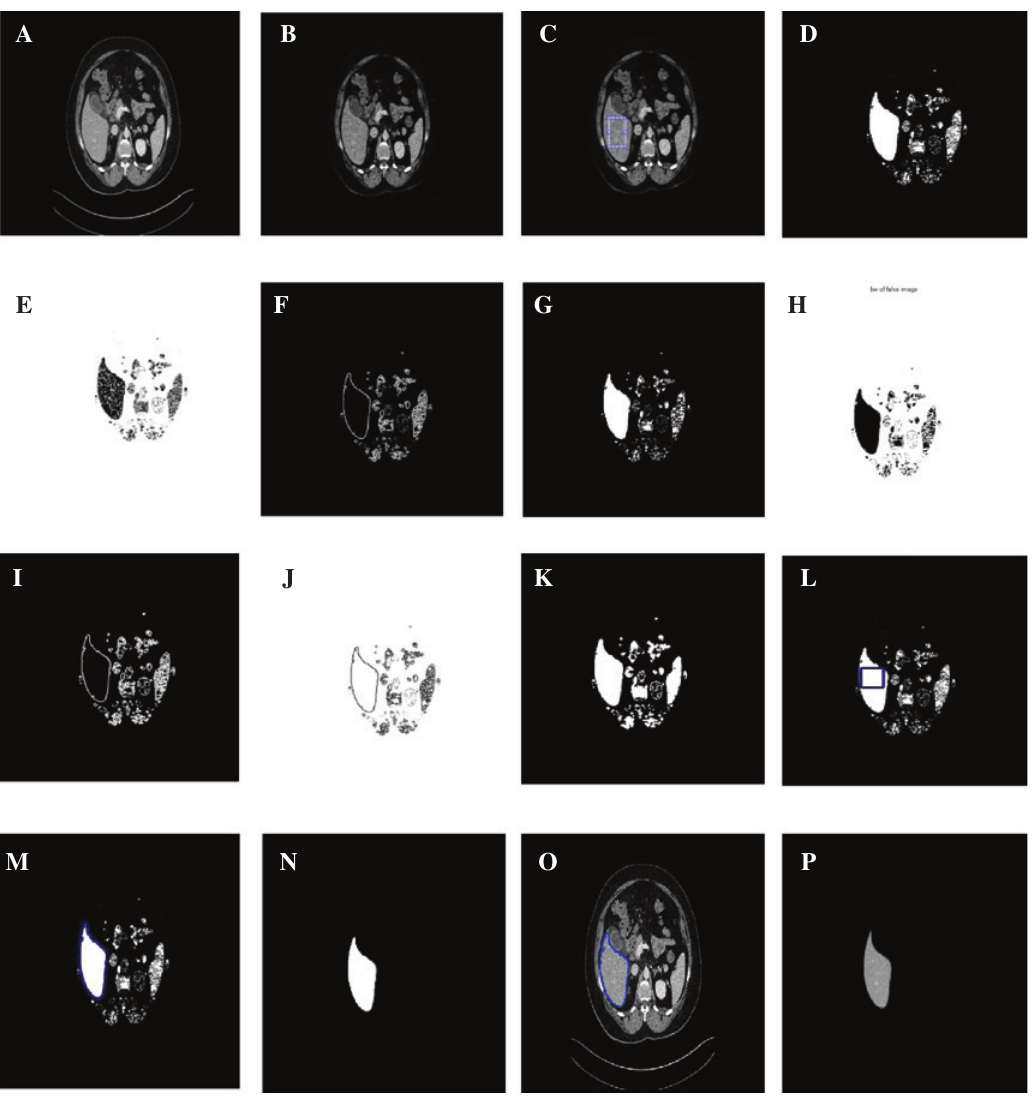
Figure 3: Illustration of liver extraction from CT scan using proposed method. (A) Original CT scan image, (B) median filter image, (C) cropped random section of the liver, (D) true subset image, (E) false subset image, (F) indeterminate image, (G) foreground image, (H) background image, (I) edge image, (J) homogeneity image, (K) speed function, (L) initial contour in speed function, (M) liver boundary, (N) extraction of the liver from the CT scan image, (O) liver with boundary in CT scan and (P) ground truth